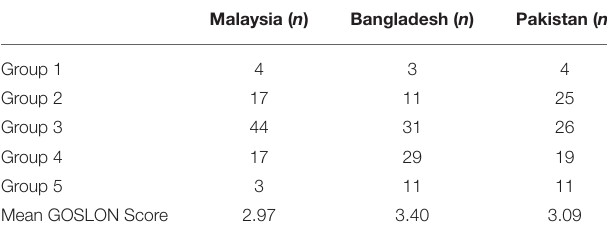
TABLE 1 | The score distribution and the mean GOSLON score of UCLP subjects of three populations using GY.